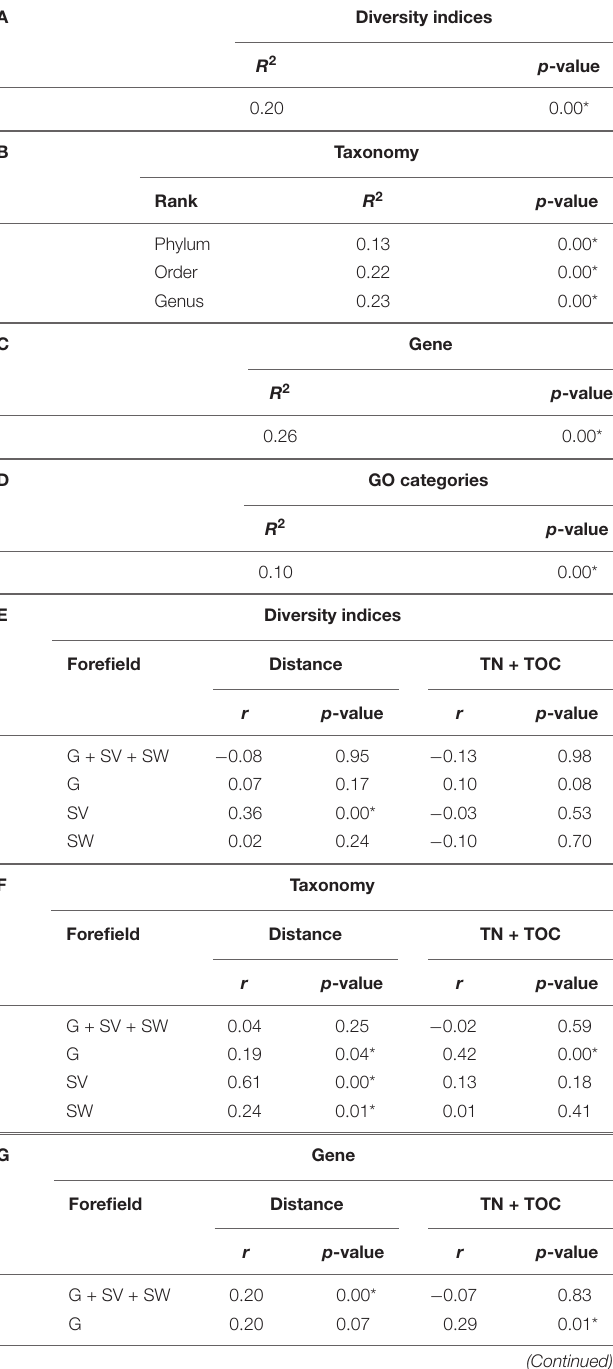
TABLE 3 | PERMANOVA performed between the distance from the ice edge and the diversity index dataset (A) ; taxonomy dataset at the phylum, order, and genus level (B) ; gene dataset (C) ; and the GO dataset (D) . Mantel test performed to calculate the correlation between the distance from the ice edge (distance) and the geochemical dataset (i.e., TN + TOC) with the diversity index dataset (E) , taxonomy dataset at the genus level (F) , gene dataset (G) , and the GO dataset (H) . Each of these four datasets were tested with all the samples from the three different proglacial systems (G + SV + SW), only the G system, only the SV system, and only the SW system. The symbol * is reported for significant R 2 and r values where the statistic p -value <